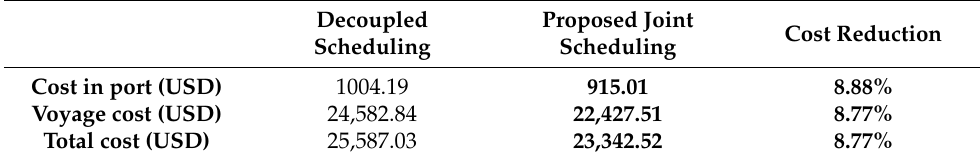
Table 10. Cost comparison of jointed and decouple